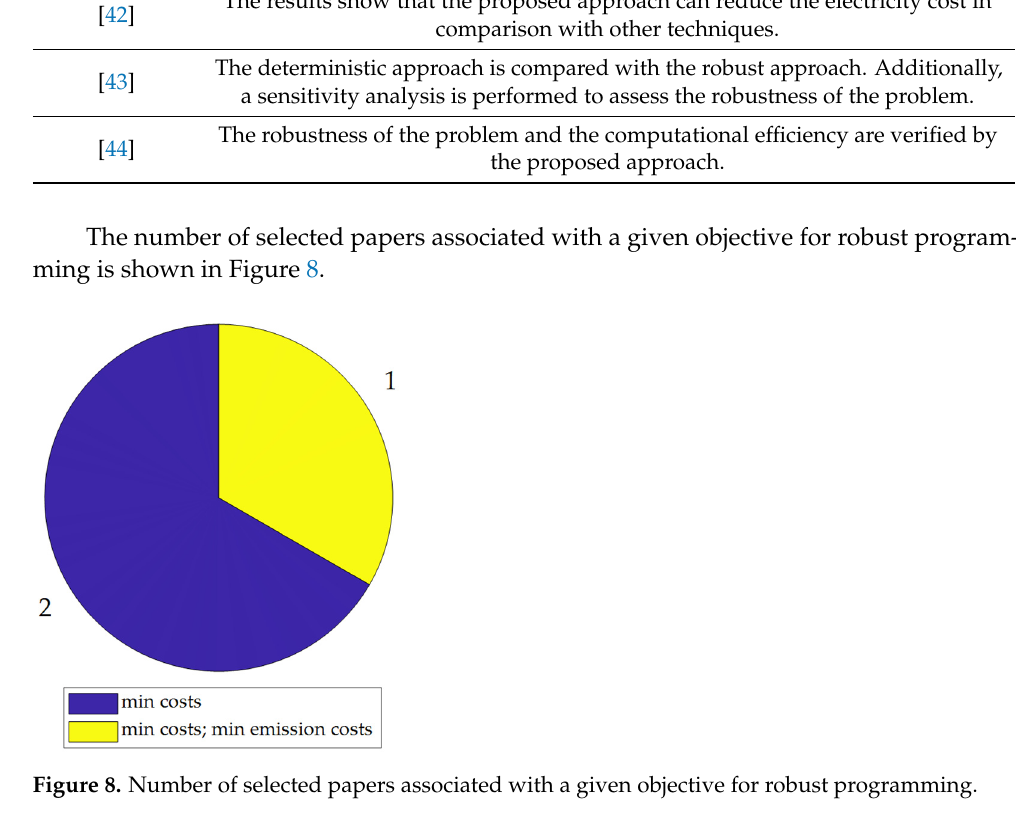
Table 12. Findings of selected papers associated with robust programming. Reference